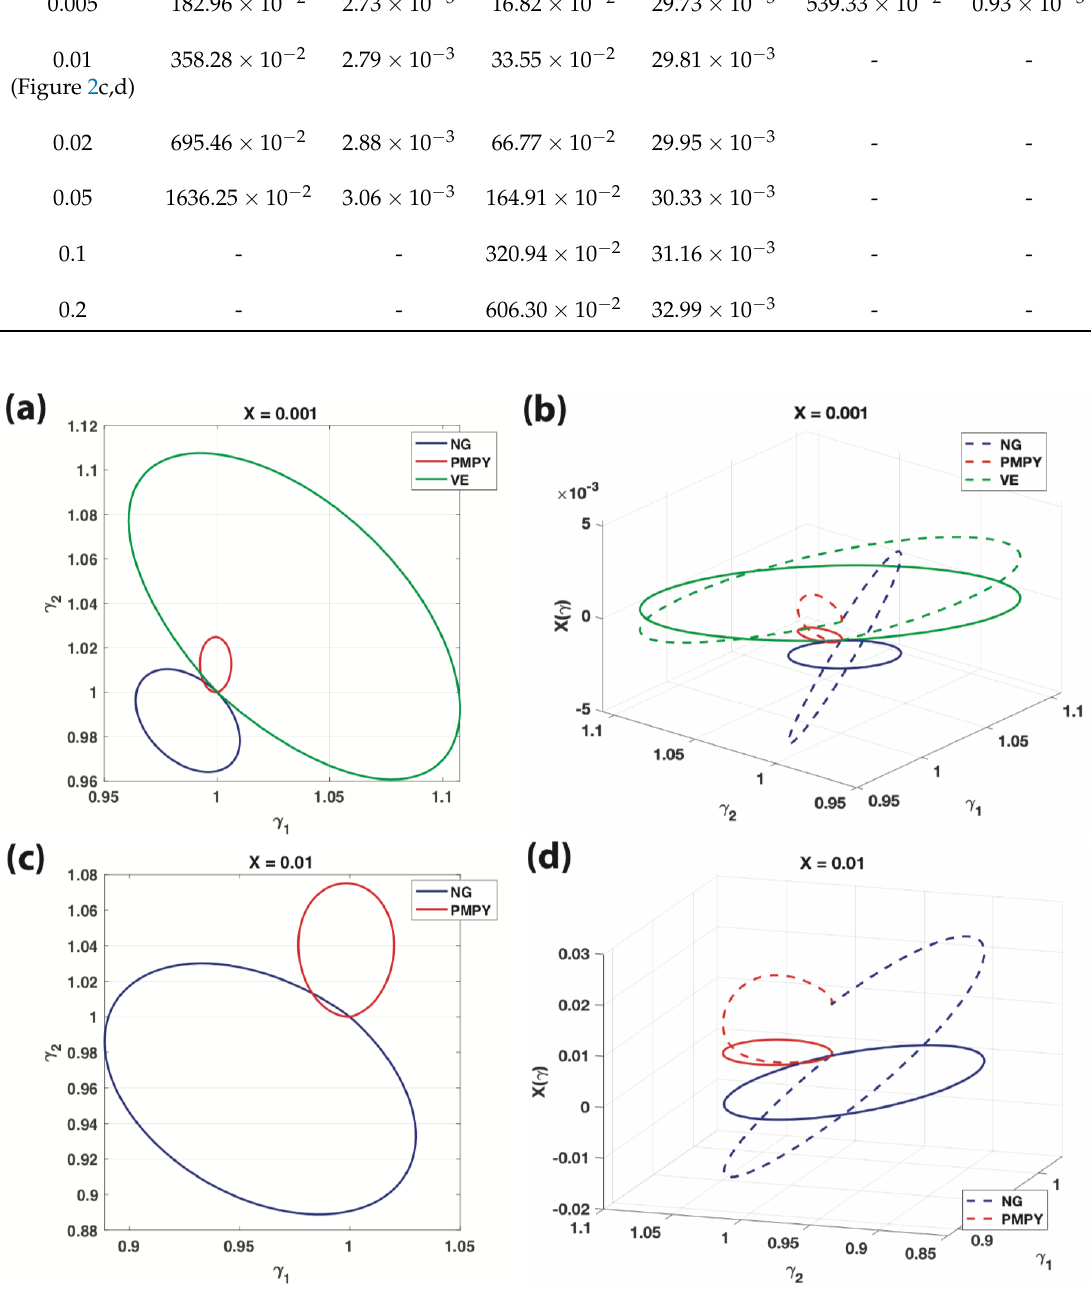
Figure 2. Optimal strokes of NG 3-sphere, PMPY 2-sphere and VE 3-sphere swimmers. ( a , c ) give the γ -paths of the optimal strokes of the NG (blue), PMPY (red) and VE (green) swimmers, when X ( γ ) = 0.001, 0.01, respectively. ( b , d ) give the optimal stroke trajectories X ( γ ( t )) , t ∈ [ 0,1 ] (dashed lines) corresponding to the γ -paths (solid lines). ( γ 1 , γ 2 ) = ( l 1 , l 2 ) for NG swimmer; ( γ 1 , γ 2 ) = ( l , a 1 ) for PMPY; ( γ 1 , γ 2 ) = ( a 1 , a 3 ) for VE. All strokes start from ( γ 1 ( 0 ) , γ 2 ( 0 )) = ( 1,1 )